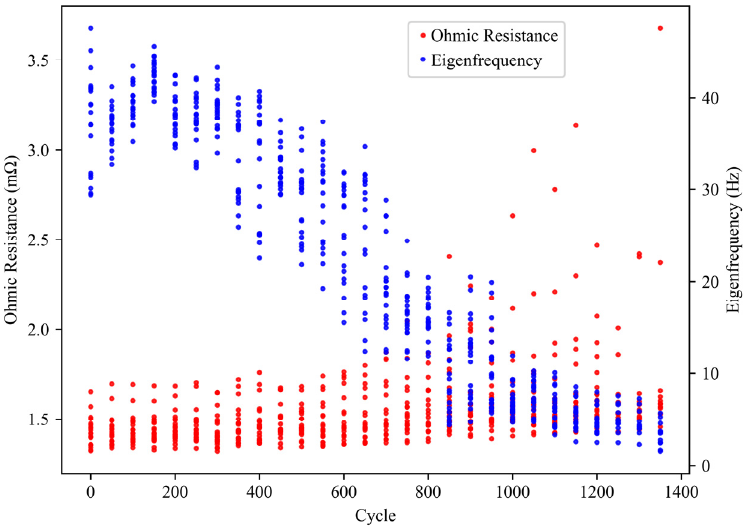
Figure 15. Changes of ohmic resistance and eigenfrequency of all cells during aging cycles.